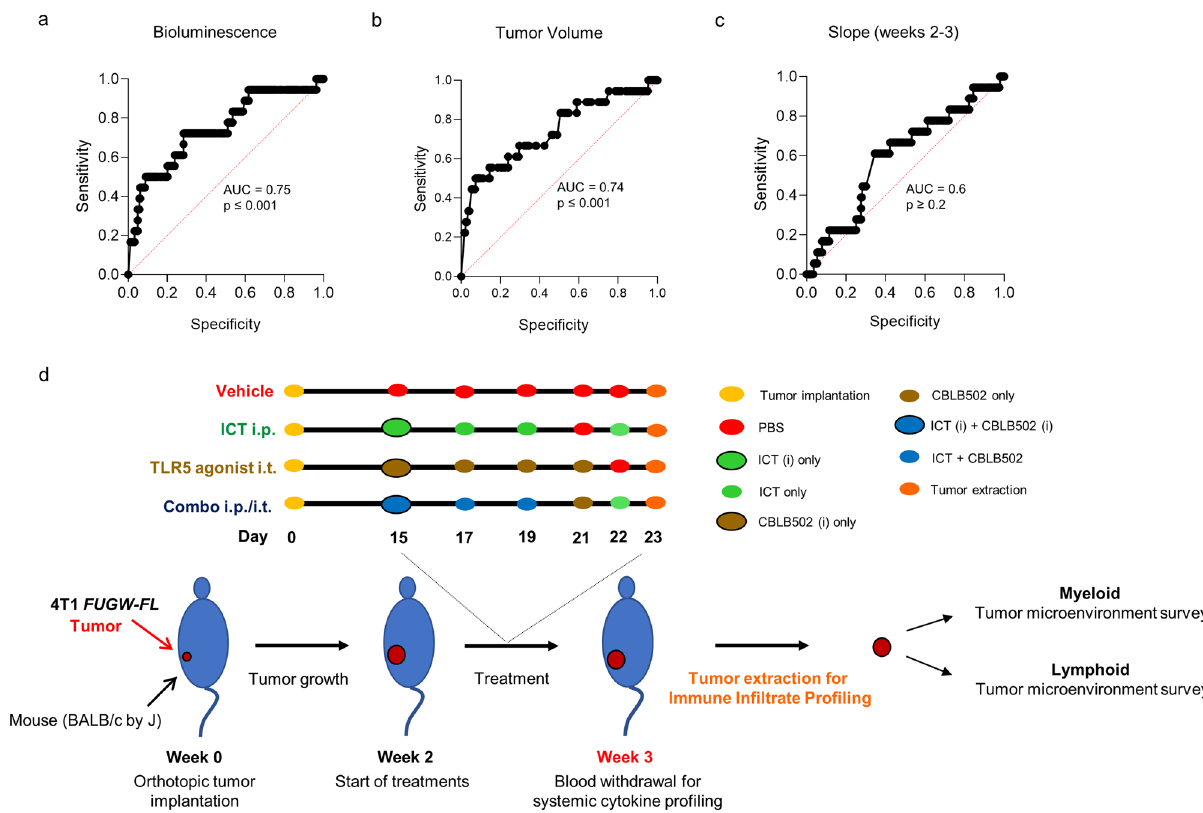
Fig. 5 ROC curve and experiment design for cytokine and tumor immune experiment. ROC curves comparing sensitivity and speci fi city for overall survival by a bioluminescence (total photon fl ux) at week 3, b tumor volume at week 3, and c tumor-volume slope between weeks 2 and 3. d Treatment diagram for euthanized mice used for tumor immune pro fi